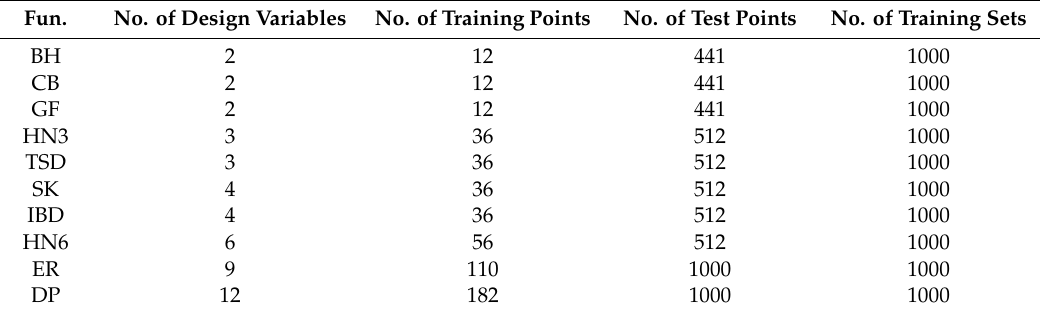
Table 2. Summary of training and test data used for each test problem.